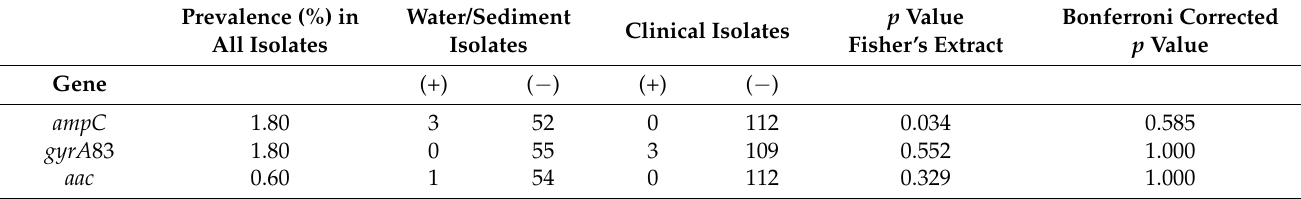
Figure 2. Maximum likelihood phylogeny constructed using core single nucleotide polymorphisms (SNPs) identified among the genomes of 55 STEC isolates recovered from water and sediments (isolate prefix FWS and LMFS) and 112 Canadian clinical STEC isolates and reference strain EDL933. Isolates of the same serotype with identical antimicrobial resistance (AMR) pattern or lacking AMR genes were omitted from the tree; tip colors denote different serotypes. Black squares in the matrix denote the presence of antibiotic resistance determinants common to the isolates. The scale corresponds to the number of substitutions per site. Resistance determinant functions: ampC : mutation in the promoter region of the chromosomal ampC gene; gyrA 83 mutation: mutation in DNA gyrase codon 83; aac : aminoglycoside-3-acetyltransferase; aadA : aminoglycoside- 3-adenylyltransferase; aph : aminoglycoside-3-phosphotransferase; bla CMY-2: AmpC β -lactamase; bla CTX-M: extended- spectrum β -lactamase; bla TEM: β -lactamase; catA : chloramphenicol acetyltransferase; dfrA : resistance to trimethoprim; floR : florfenicol/chloramphenicol exporter; fosA : fosfomycin thiol transferase; mphA : macrolide-2-phosphotransferase; sul1 : dihydropteroate synthase; sul2 : dihydropteroate synthase; tetA : tetracycline efflux protein; tetB : tetracycline efflux protein. Table 2. Distribution of acquired resistance genes detected in whole genome sequences of 55 STEC isolates recovered from water and sediments in the Lower Mainland of British Columbia, Canada and 112 Canadian clinical STEC isolates. Probabilities that the prevalence of specific genes were nonrandomly distributed were calculated using Fisher’s exact test. Resistance determinant functions: ampC : mutation in the promoter region of the chromosomal ampC gene; gyrA83 : mutation in DNA gyrase codon 83; aac : aminoglycoside 3-N-acetyltransferase; aadA : aminoglycoside-3-adenylyltransferase; aph : aminoglycoside-3-phosphotransferase; bla CMY-2: β -lactamase; bla CTX-M: extended spectrum β -lactamase; bla TEM: β -lactamase; catA : chloramphenicol acetyltransferase; dfrA : resistance to trimethoprim; floR : florfenicol/chloramphenicol exporter; fosA : fosfomycin thiol transferase; mphA : macrolide-2-phosphotransferase; sul1 : dihydropteroate synthase; sul2 : dihydropteroate synthase; tetA : tetracycline efflux protein; tetB : tetracycline efflux